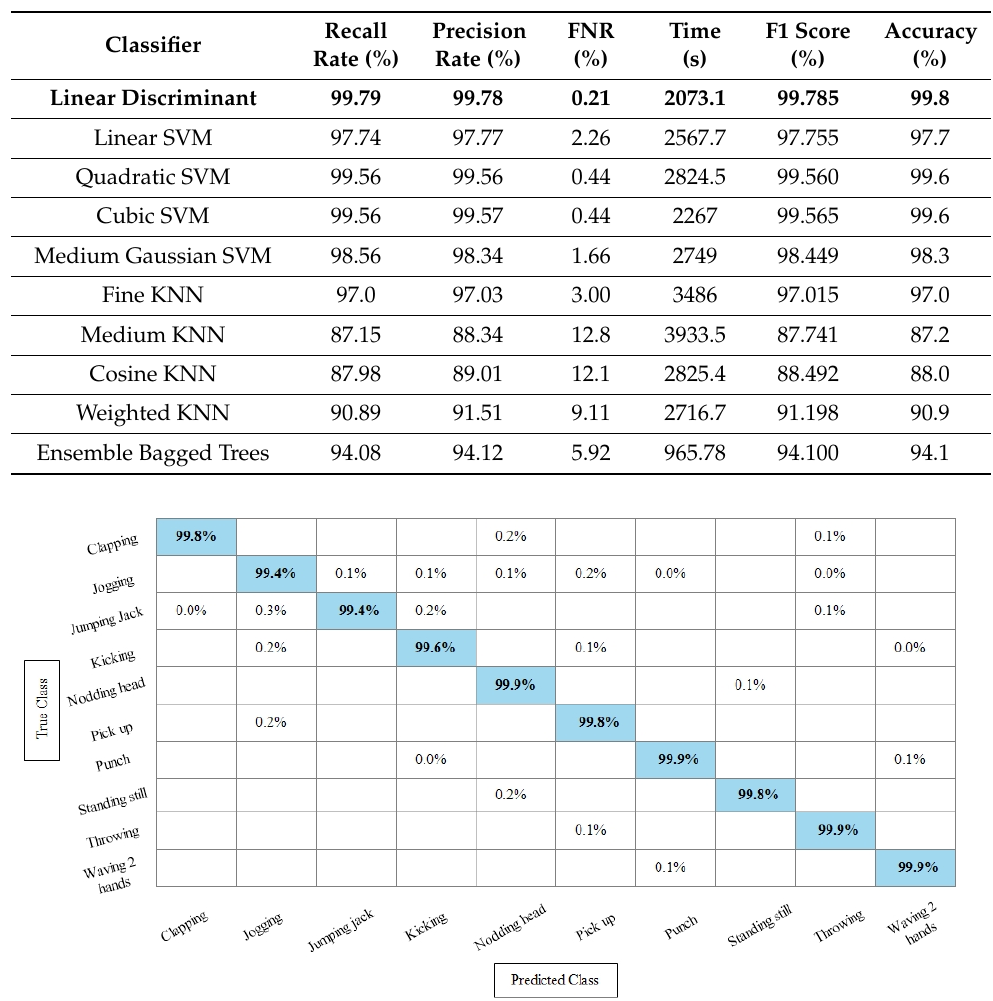
Figure 9. TPR based confusion matrix of Fine KNN using Hollywood dataset after fusion of deep features through SbE approach. Table 5. Achieved results on WVU dataset after fusion of deep features using SbE approach. The bold represents the best obtained values.